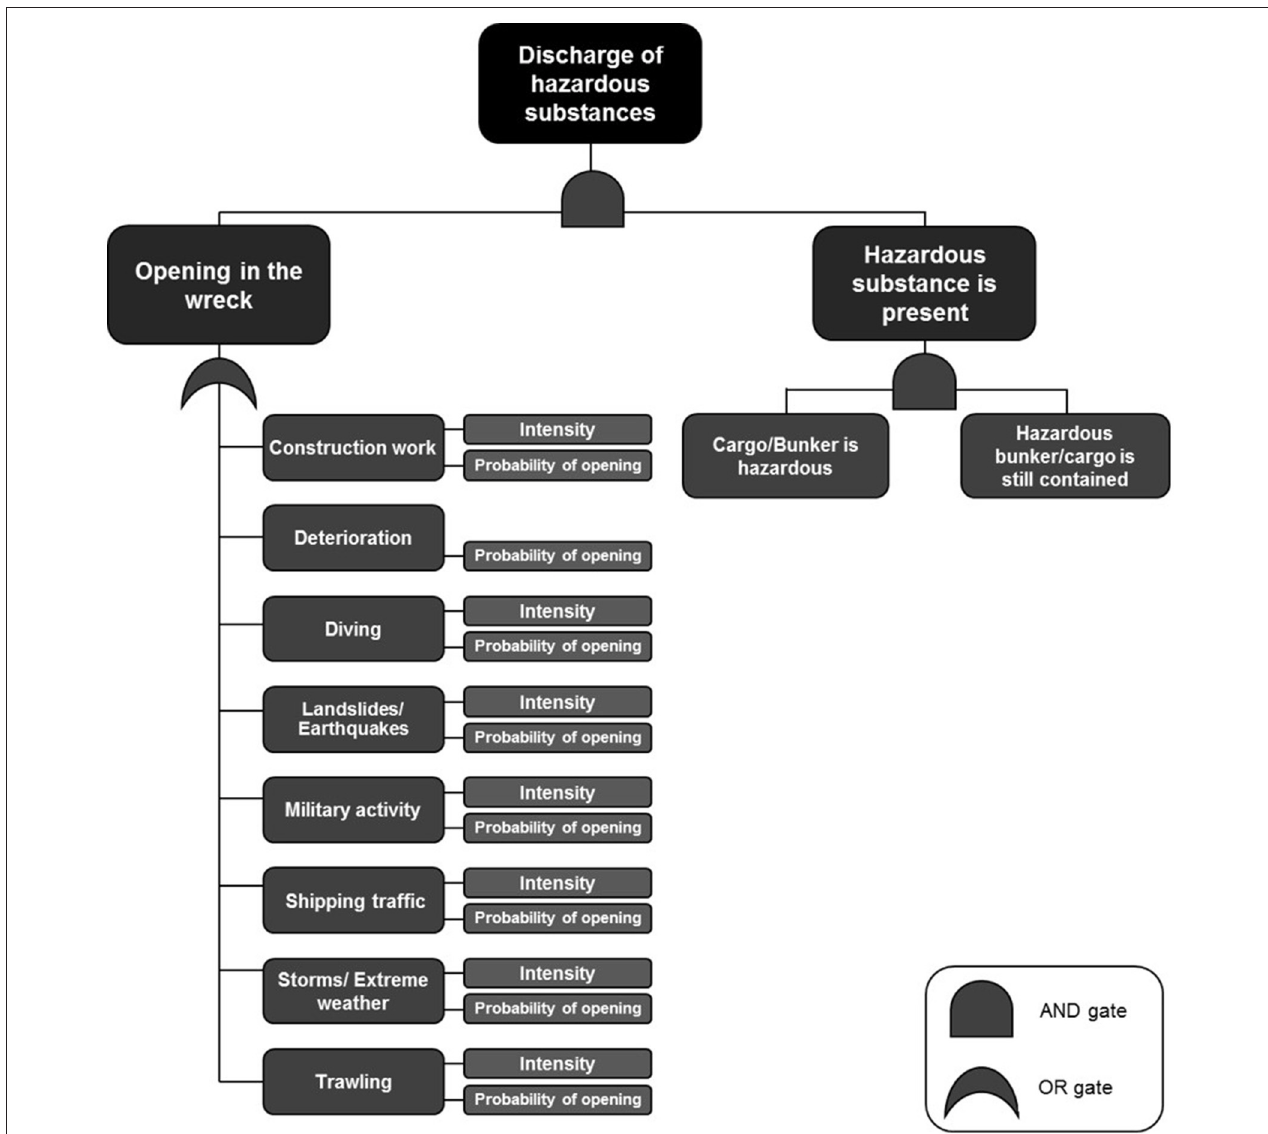
FIGURE 5 | Fault tree adapted to VRAKA. The top event “Discharge of hazardous substance” is defined by the two underlying events “Opening in the wreck” and “Hazardous substance is present.” The latter is assumed to only occur if both “Cargo/Bunker is hazardous” and “Hazardous bunker/cargo is still contained.” “Opening in the wreck” is assumed to occur due to the fault tree-defined activities, which are in turn defined by a specific probability of causing an opening and how often these activities occur for the current wreck